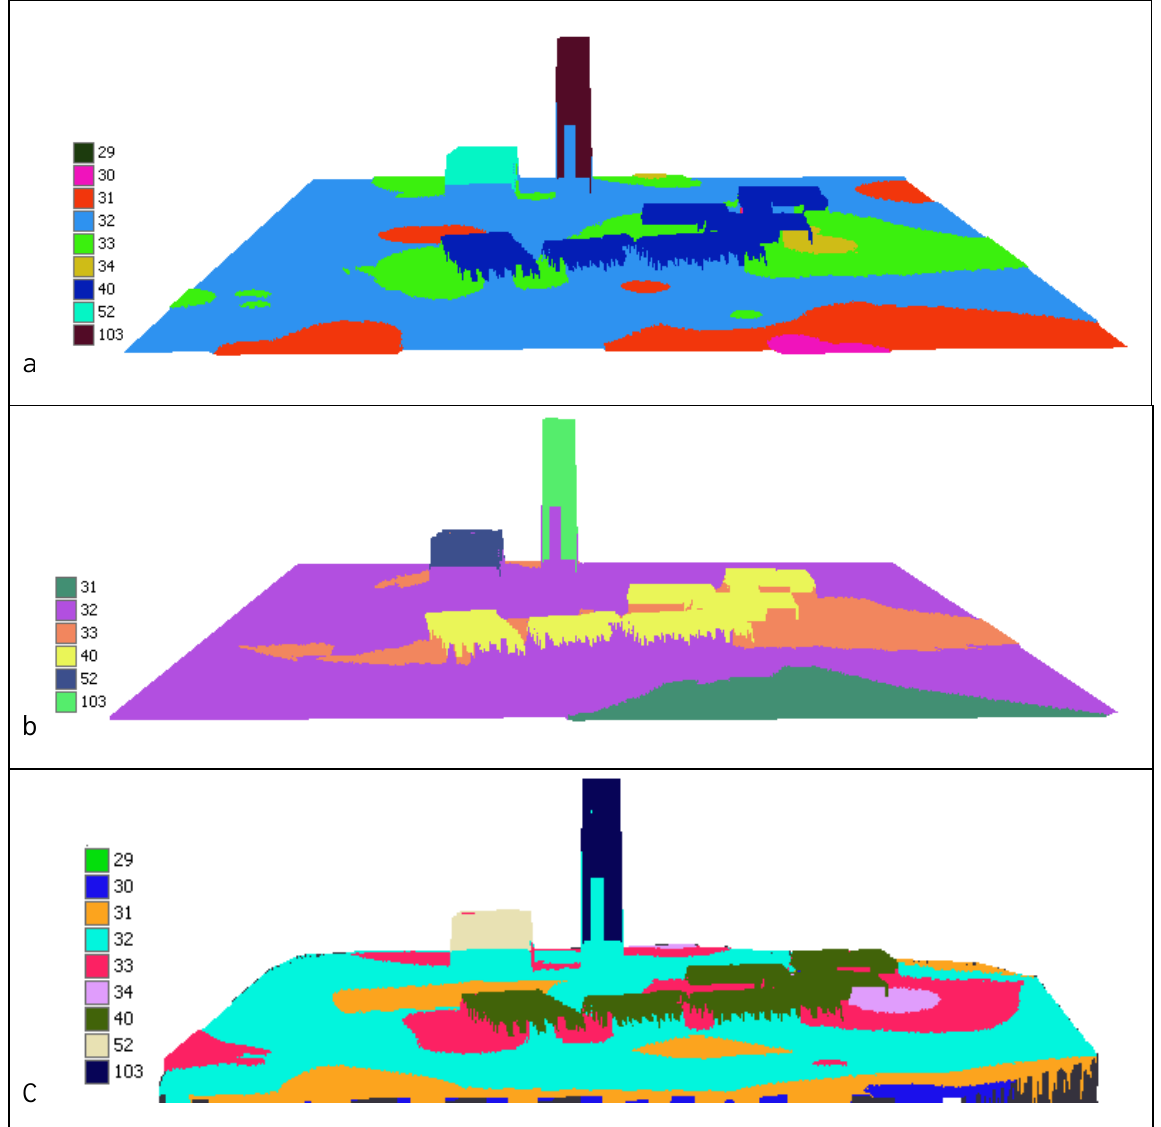
Fig. 9: 3D-color view of final DEM estimated by: a) IDW,b)ordinary kriging, c)natural